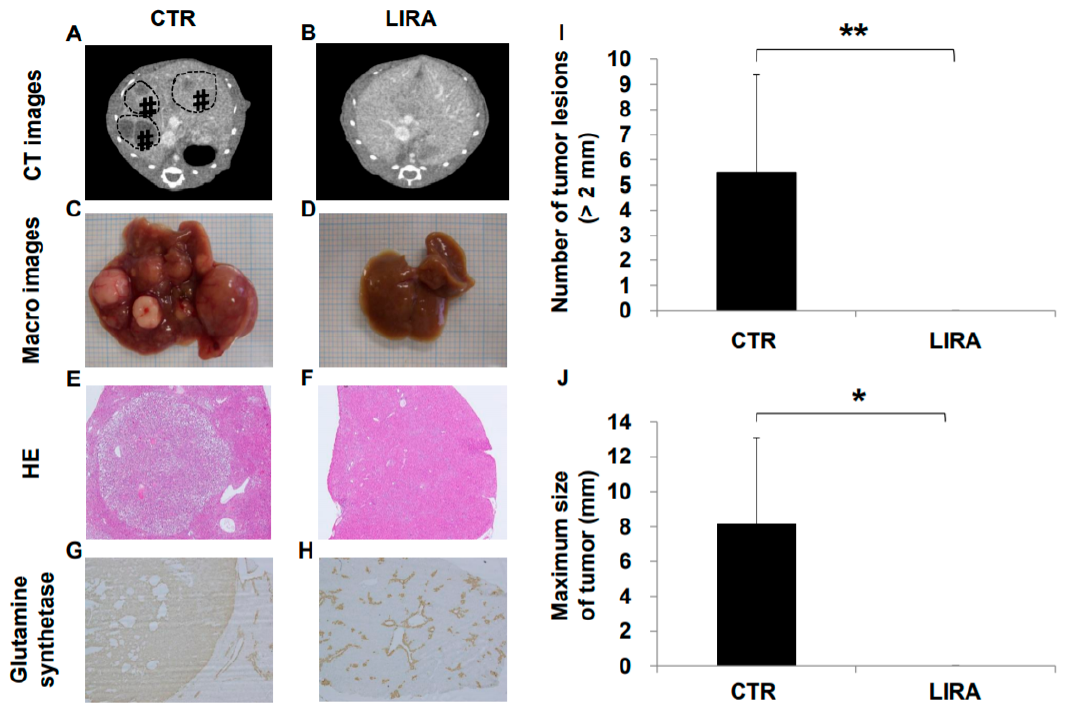
Figure 2. E ff ect of liraglutide on hepatocarcinogenesis. Representative contrast-enhanced computed tomography images of control mice (CTR) ( A ) and liraglutide-treated mice (LIRA) ( B ). # and dotted line circles denote the HCC lesions. Macroscopic image of the liver surface (CTR ( C ); LIRA ( D )). Histological images with hematoxylin and eosin staining in the CTR ( E ) and LIRA groups ( F ). Anti-glutamine synthetase staining of CTR (CTR ( G ); LIRA ( H )). Total number of tumor lesions ( I ) and maximum size ( J ) of tumors in the liver were compared between the groups ( n = 6 / group). All images and histological samples were obtained from mice at 20 weeks of age. * p < 0.05 and ** p < 0.01 vs. CTR.